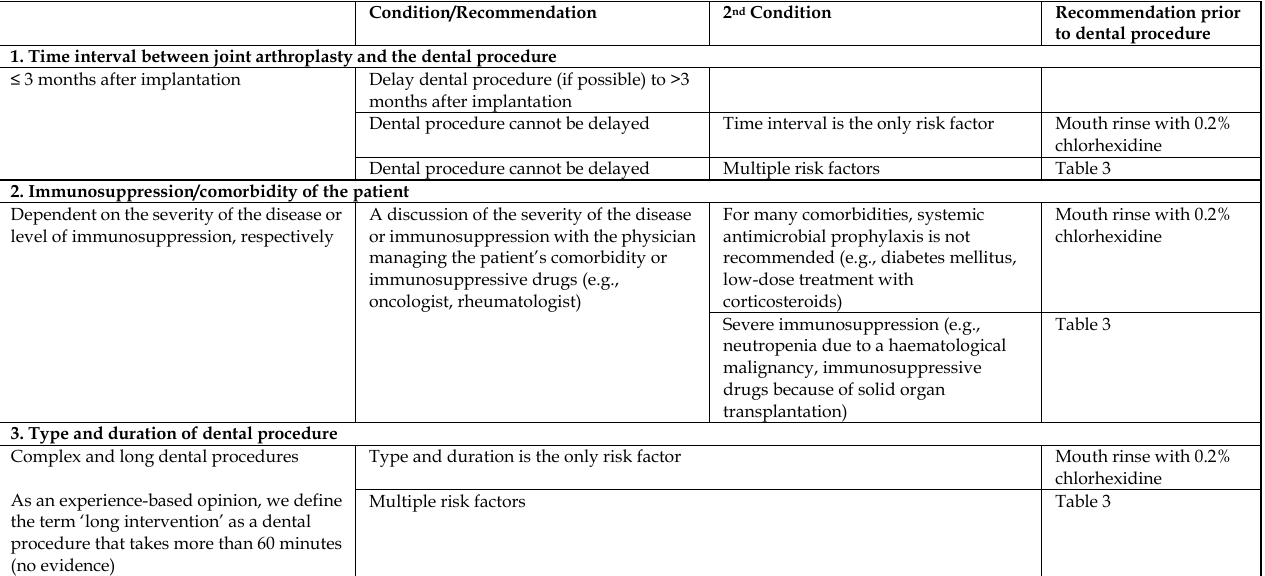
Table 2. Postulated variables reflecting an increased risk for bacterial haematogenous seeding from the oral cavity to an artificial joint. Recommendations in patients without an established infection in the oral cavity.